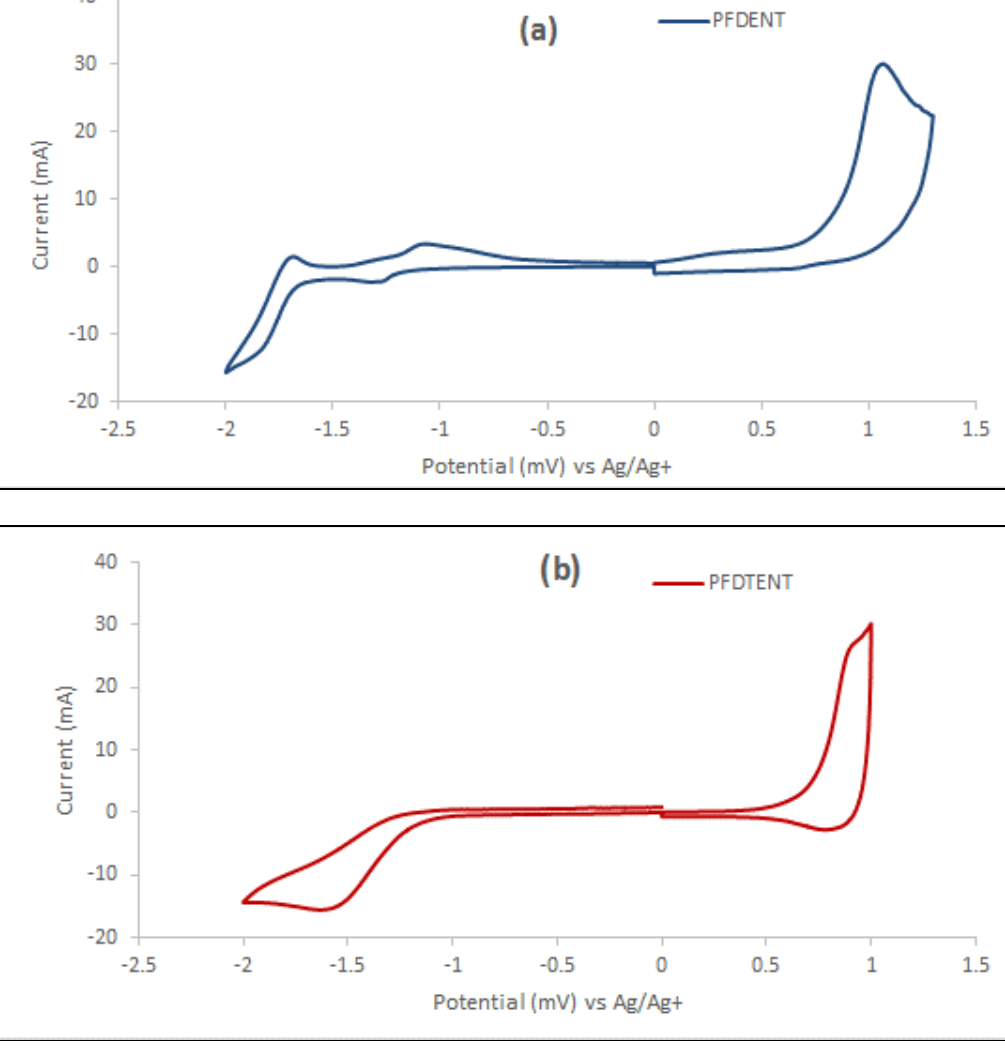
Figure 3. Cyclic voltammograms of ( a ) PFDENT and ( b ) PFDTENT .